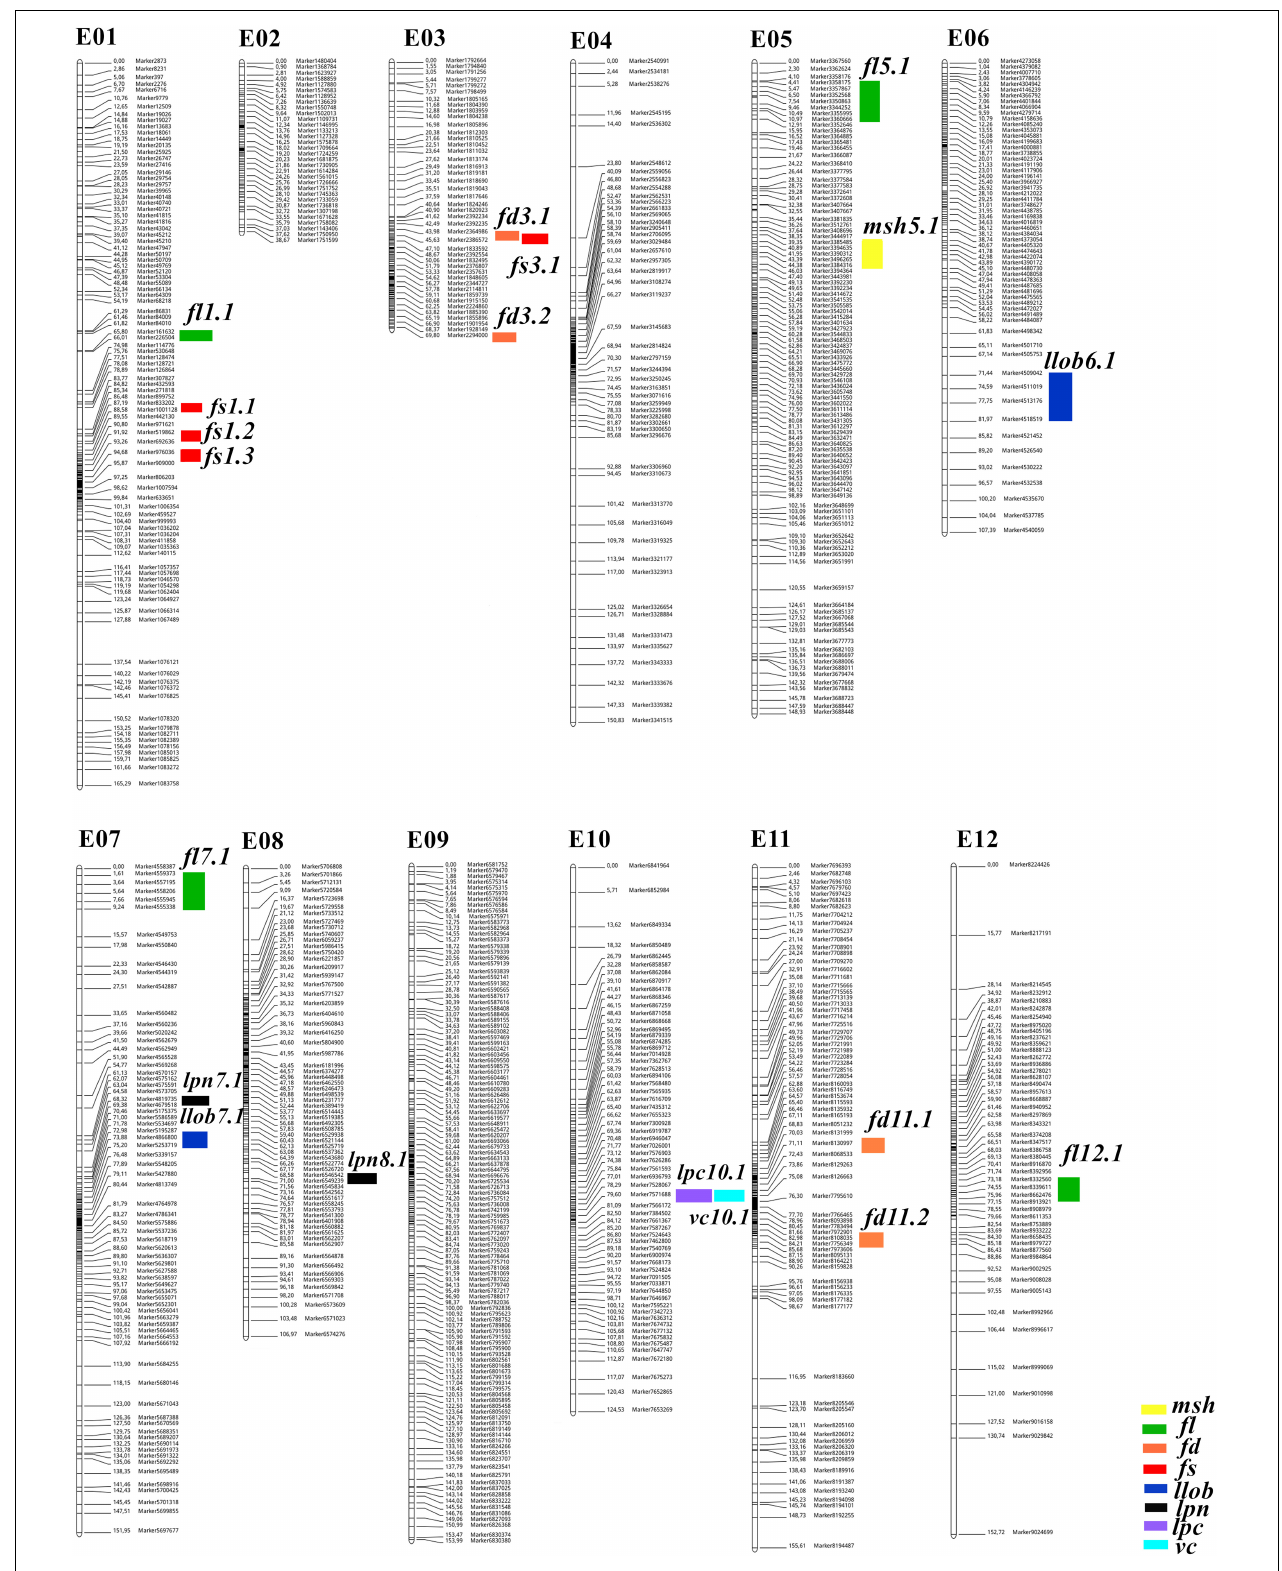
FIGURE 2 | SNP-based genetic linkage map of the interspecific F 2 population showing positions of QTLs. The numbers to the right of each LG indicate genetic distance (cM) between adjacent markers. The color bars refer to QTLs detected for the eight traits.